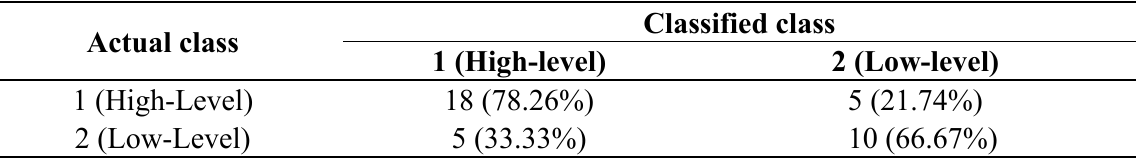
Table 11. RST-KNN model (model VIII) results with only significant variables.